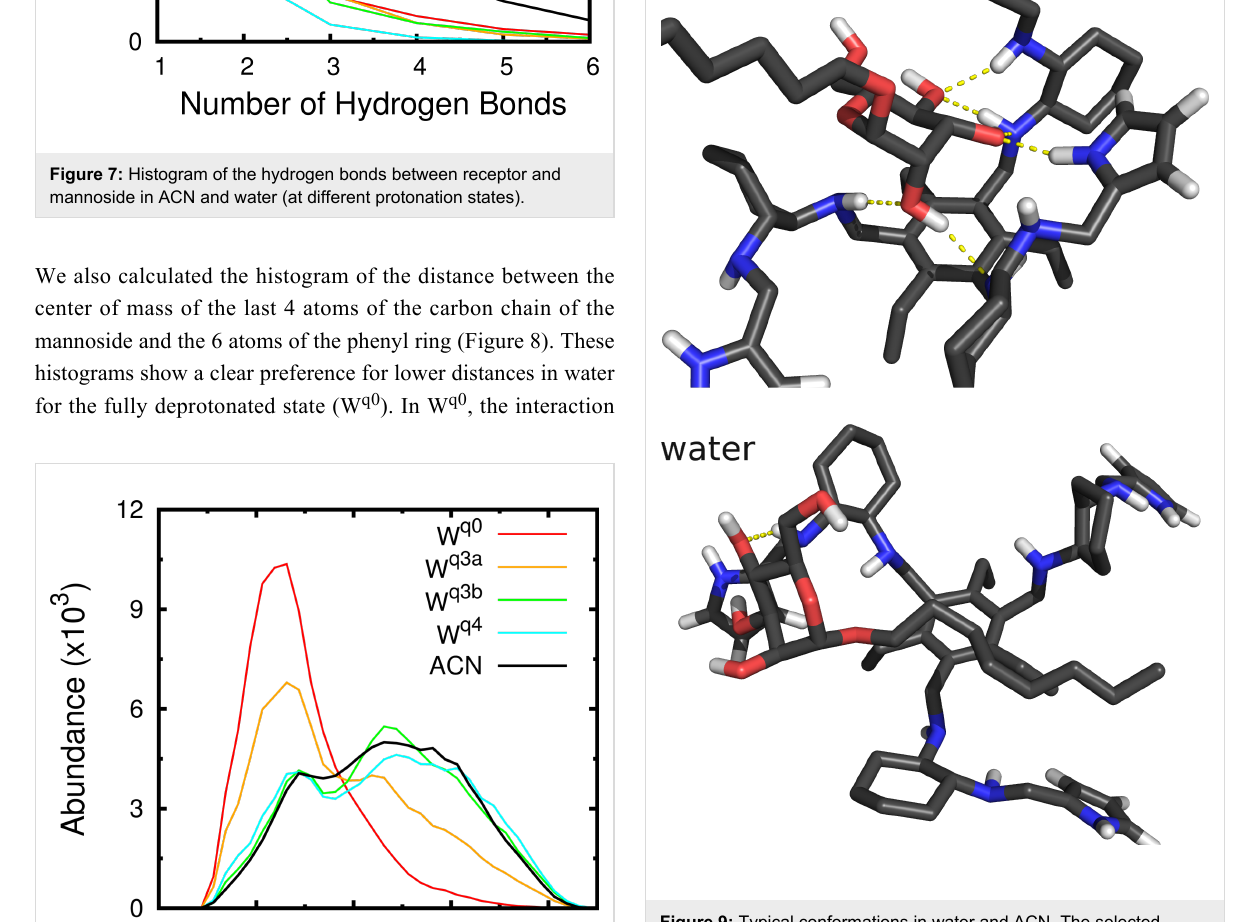
Figure 9: Typical conformations in water and ACN. The selected conformations have 6 hydrogen bonds in ACN and 1 in